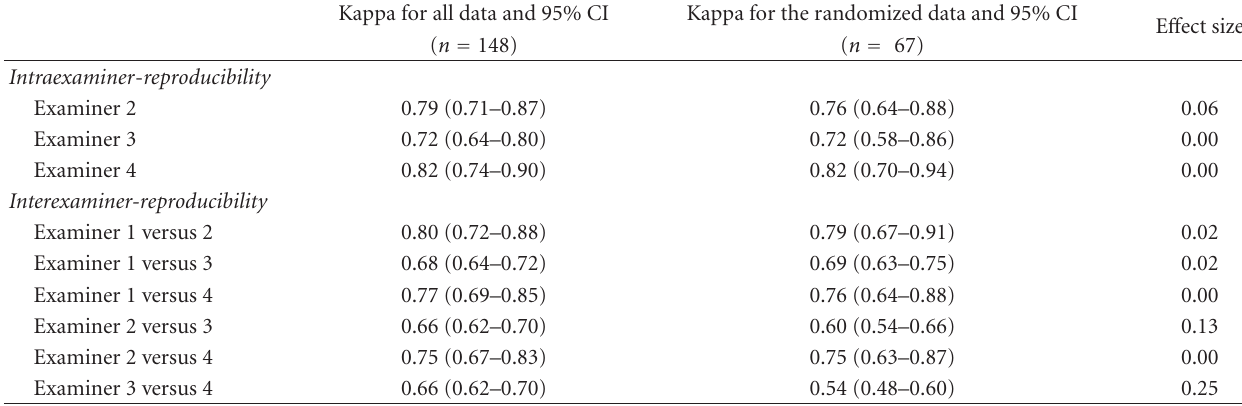
Table 3: Weighted kappa values for inter- and intraexaminer-reproducibility for visual ICDAS examinations, 95% confidence intervals and the e ff ect